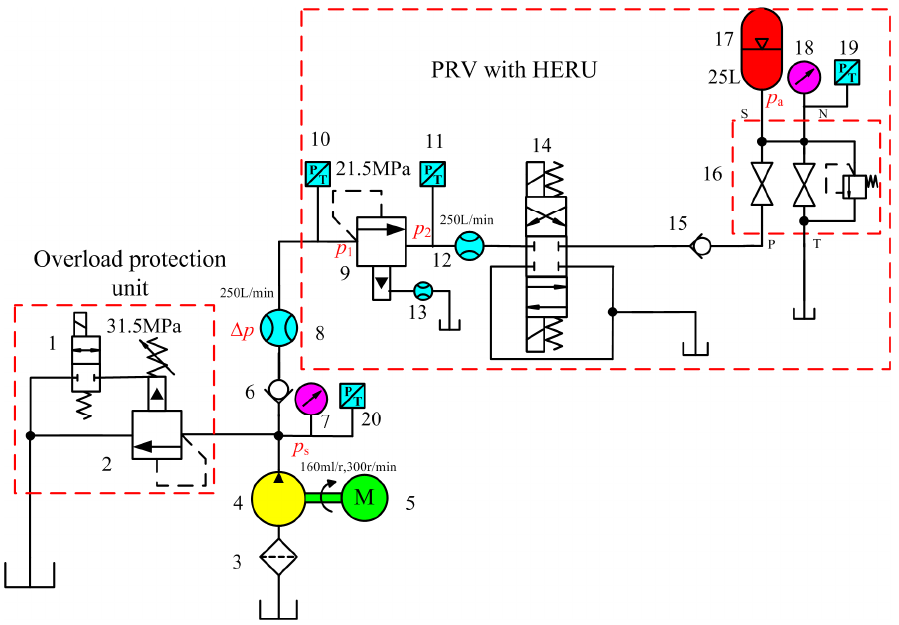
Figure 3. Principle diagram of the test for the PRV with HERU (1—2/2 Solenoid directional valve; 2—Safety valve; 3—Filter; 4—Fixed displacement pump; 5—Electric variable frequency motor; 6 and 15—Check valve; 7 and 18—Pressure gauge; 8, 12, and 13—Flow meter; 9—PRV; 10, 11, 19, and 20—Pressure sensor; 14—3/4 Solenoid directional valve; 16—Safety shutoff valve; 17—HA (HERU)).